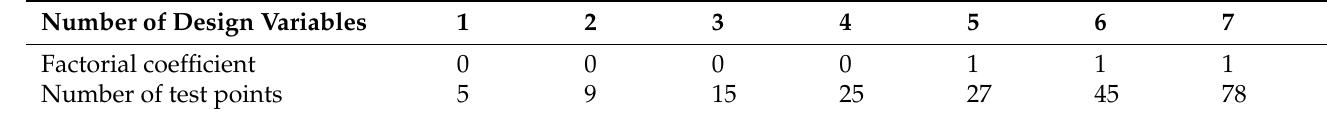
Table 6. Number of design variables and test points.